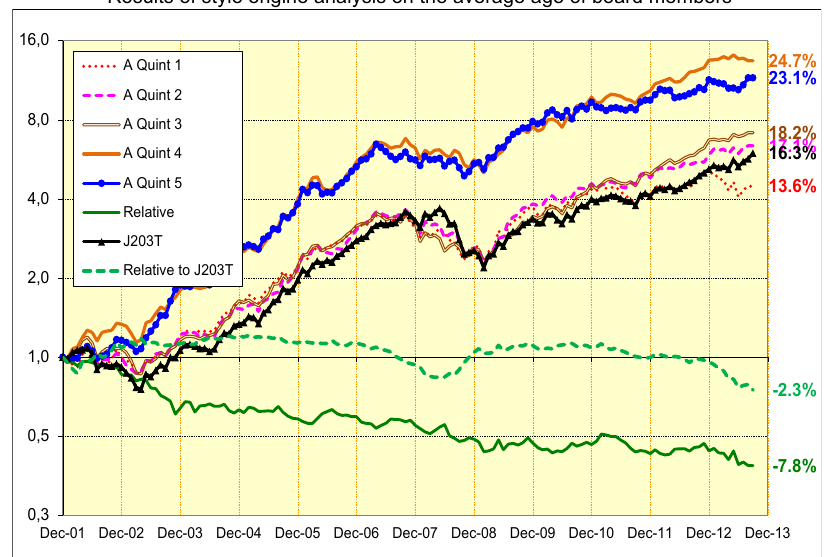
The green price relative (solid line at bottom of chart) between quintiles 1 and 5 shows a steady